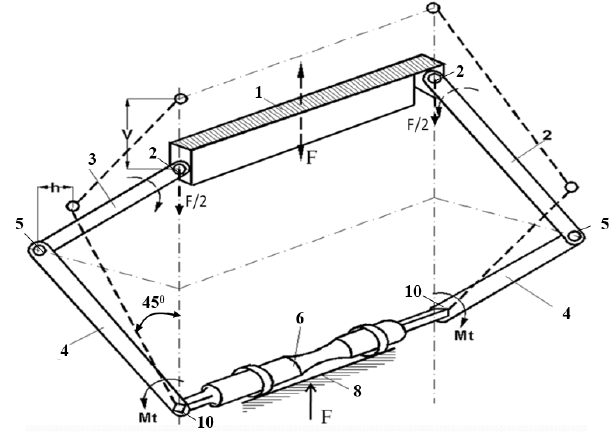
Figure 4. Device diagram—force F, displacement v, and moments M t .